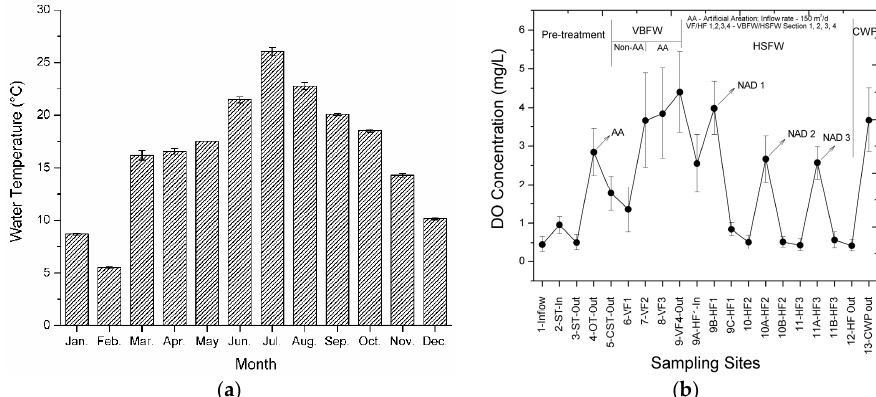
Figure 2. The water temperatures and dissolved oxygen (DO) levels in the studied hybrid system. ( a ) Average monthly water temperatures; ( b ) Annual average DO concentrations along with the flow routes of the investigated hybrid constructed wetland (CW).